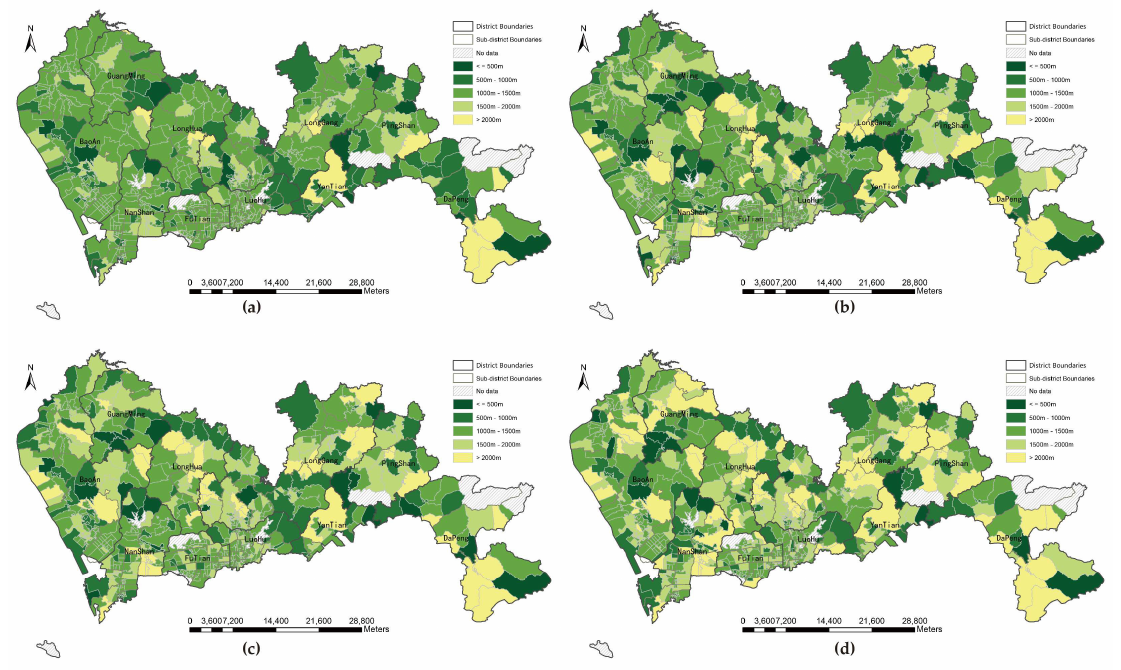
Figure 3. Proximity to community parks in threshold of 2 km by four types of distance: ( a ) Euclidean distance; ( b ) walking distance; ( c ) bicycling distance; ( d ) driving distance.